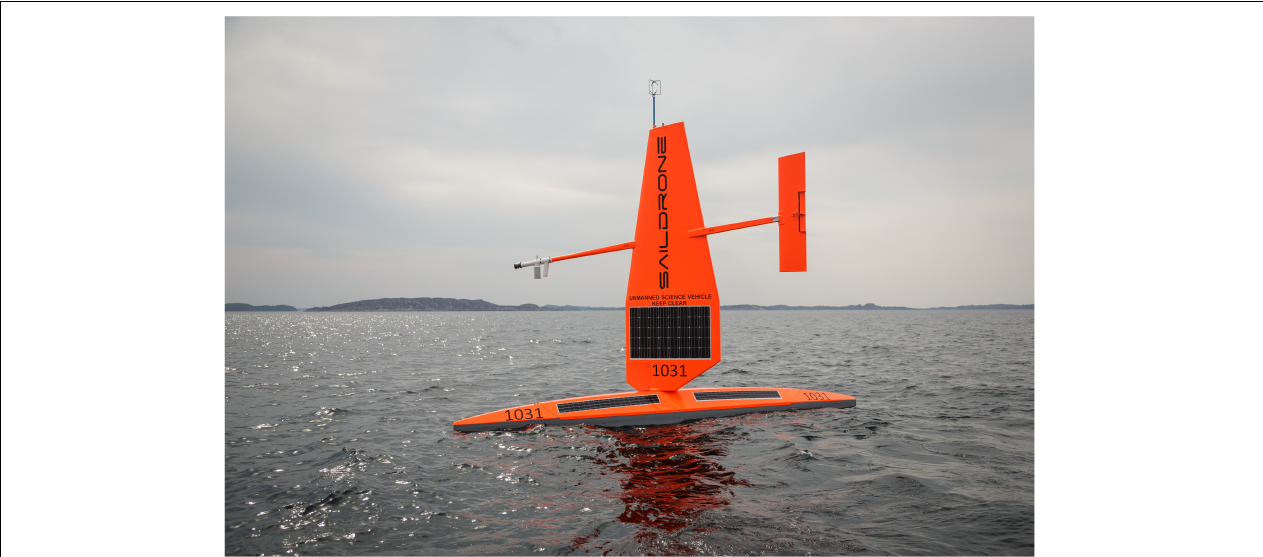
FIGURE 2 | SailDrone deployment in Norway (source: Erlend A. Lorentzen/Institute of Marine Research).